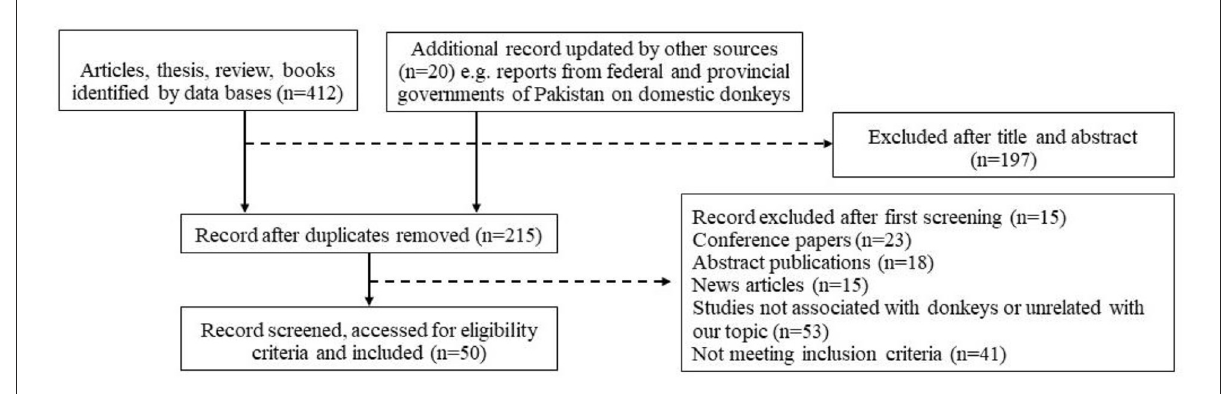
FIGURE2 Flow chart representing the selection of studies for inclusion criteria for the systematic review of donkeys and their welfare and healthcare management strategies.